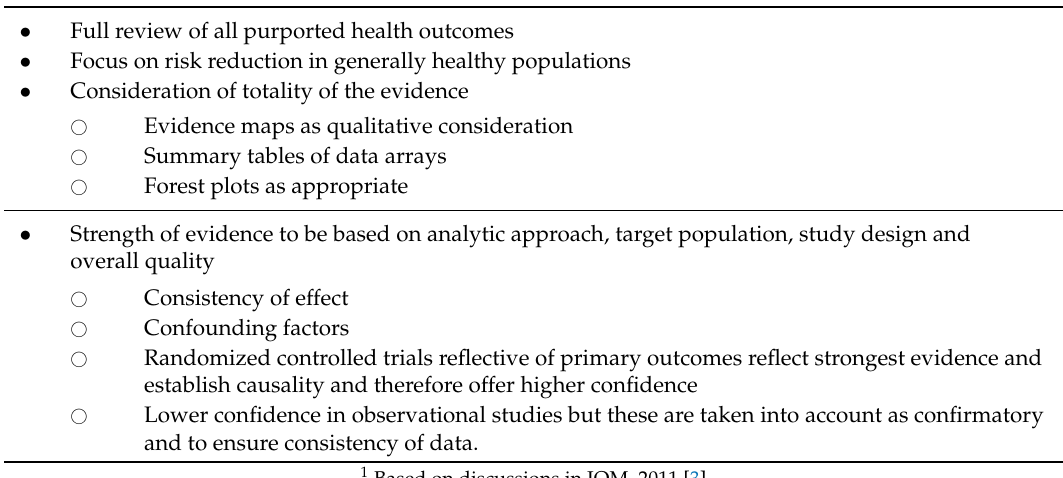
Table 3. Evidence evaluation components 1 : Dietary Reference Intake review for calcium and